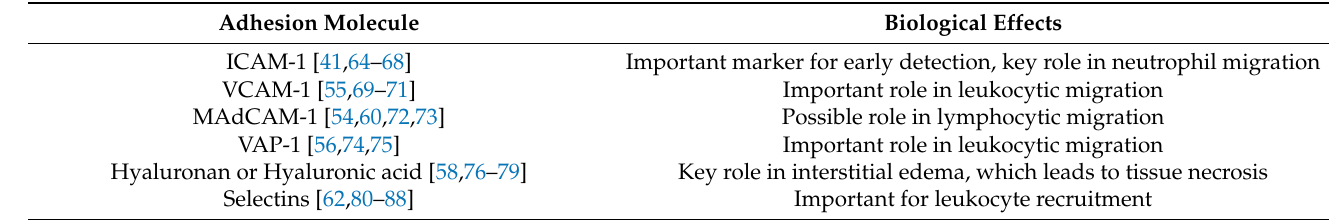
Table 1. Biological effects of adhesion molecules in acute